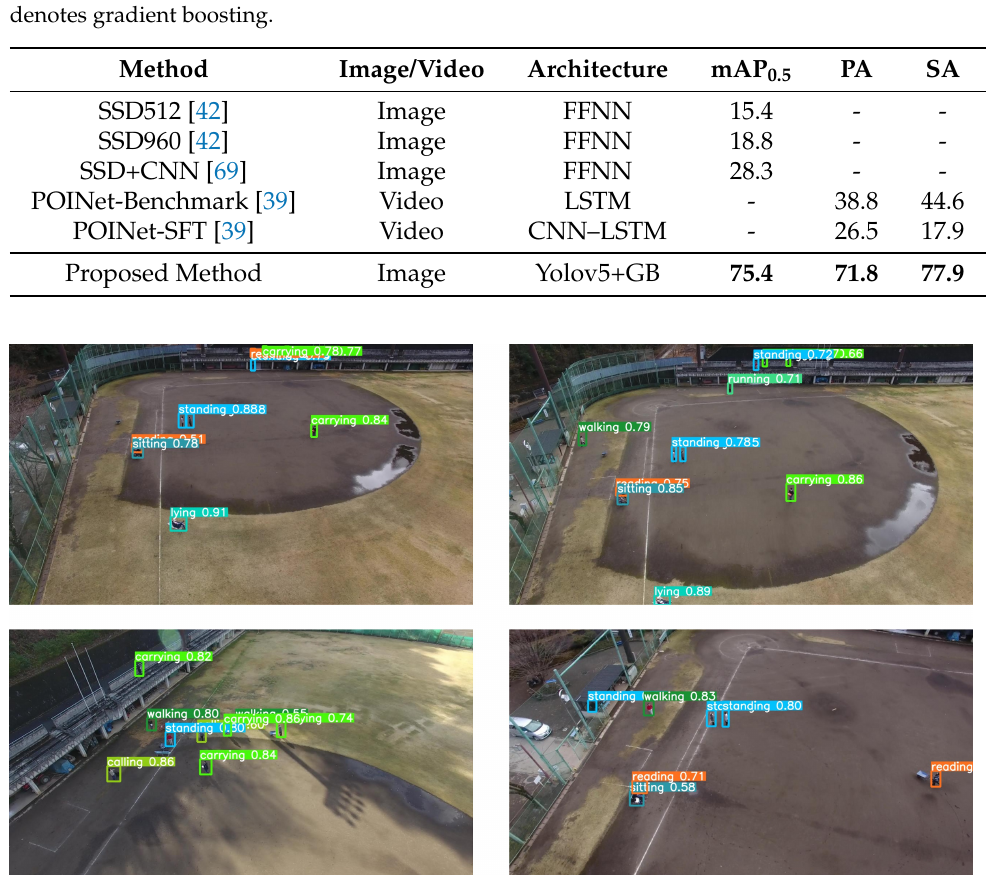
Figure 5. Inference results for action detection in drone images. Each color bounding box corresponds to a separate action